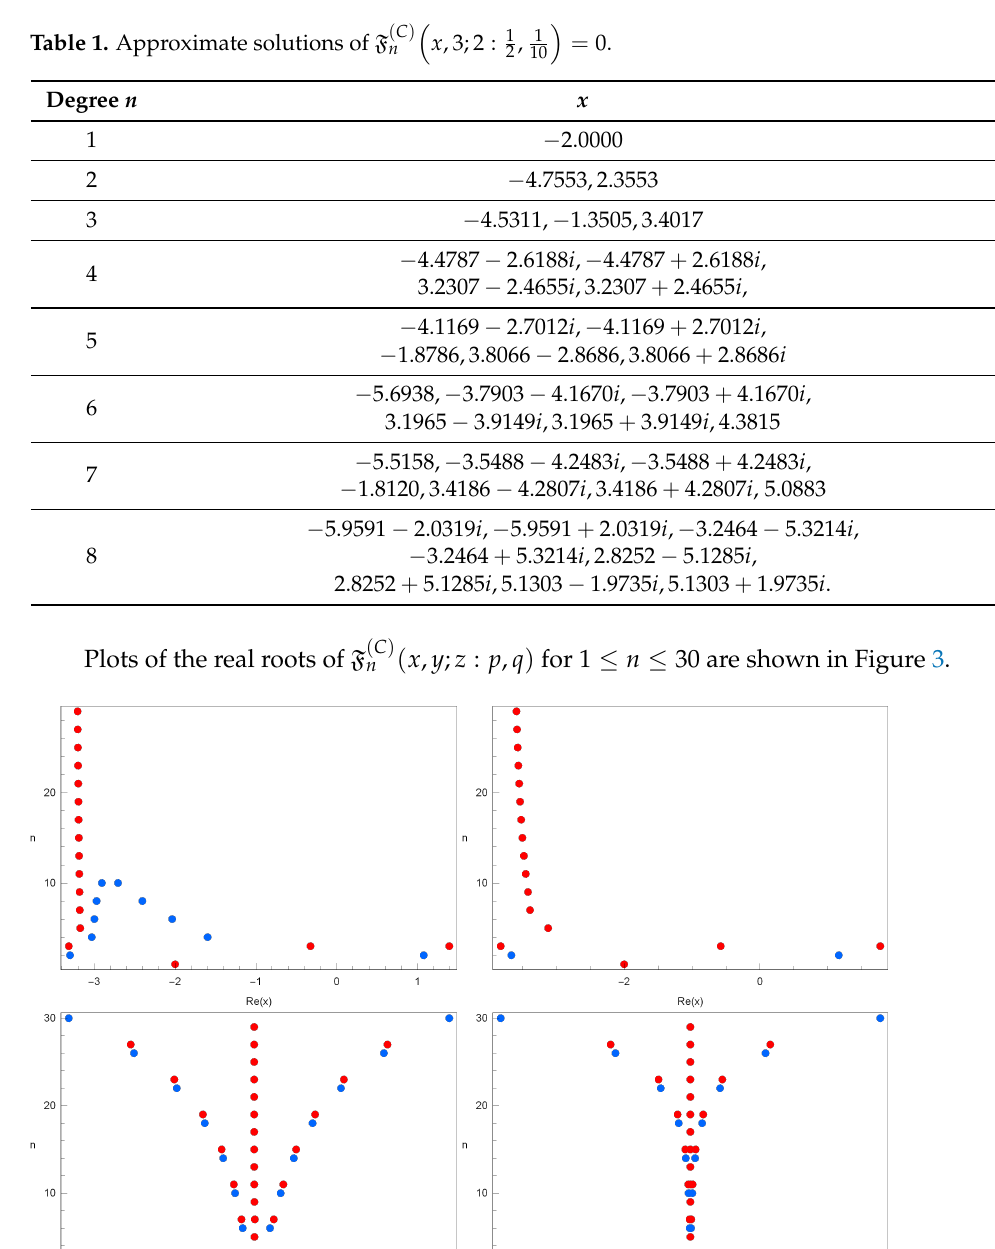
Table 1. Approximate solutions of F